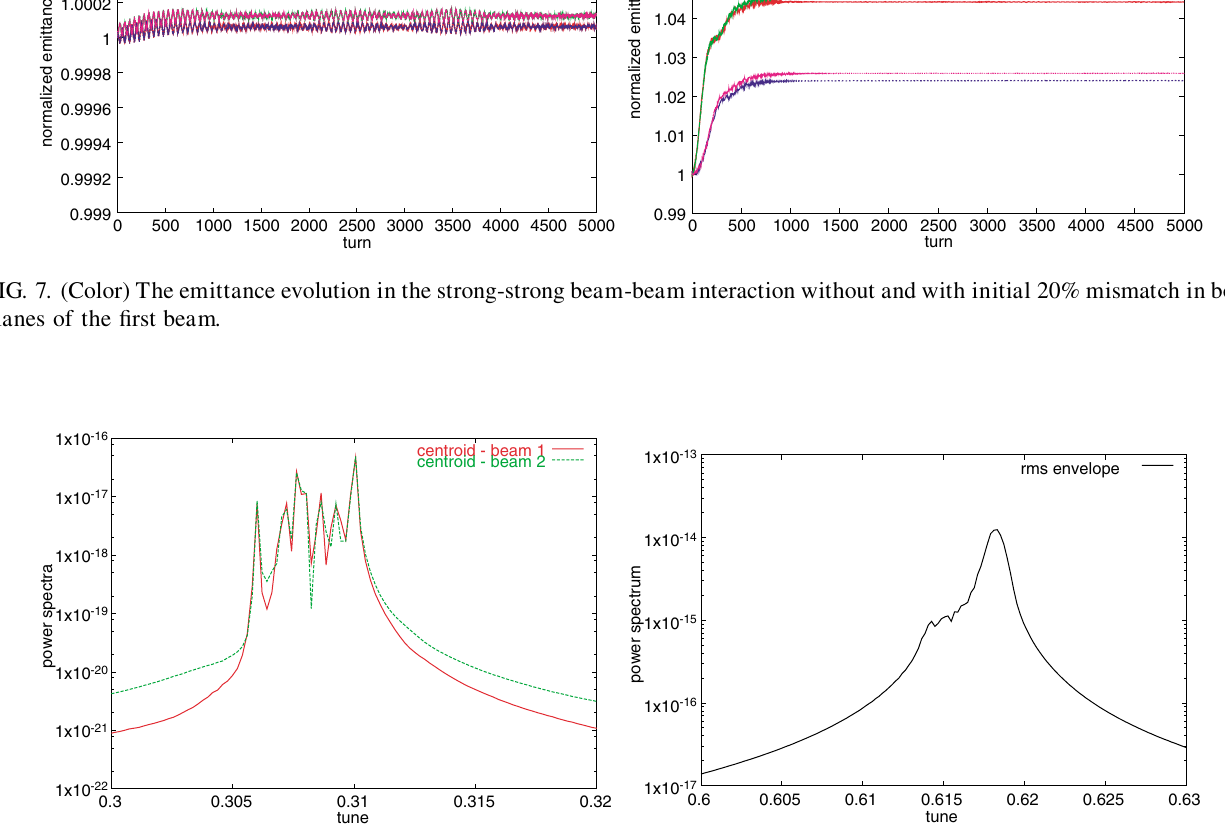
FIG. 8. (Color) The power spectra of the horizontal centroid motion of both beams (left panel) and the power spectrum of the horizontal envelope oscillation of the first beam (right